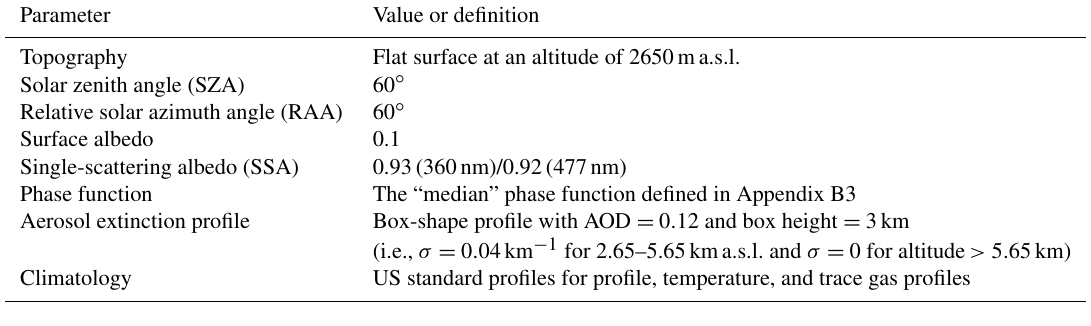
Table B1. The common settings for sensitivity studies.